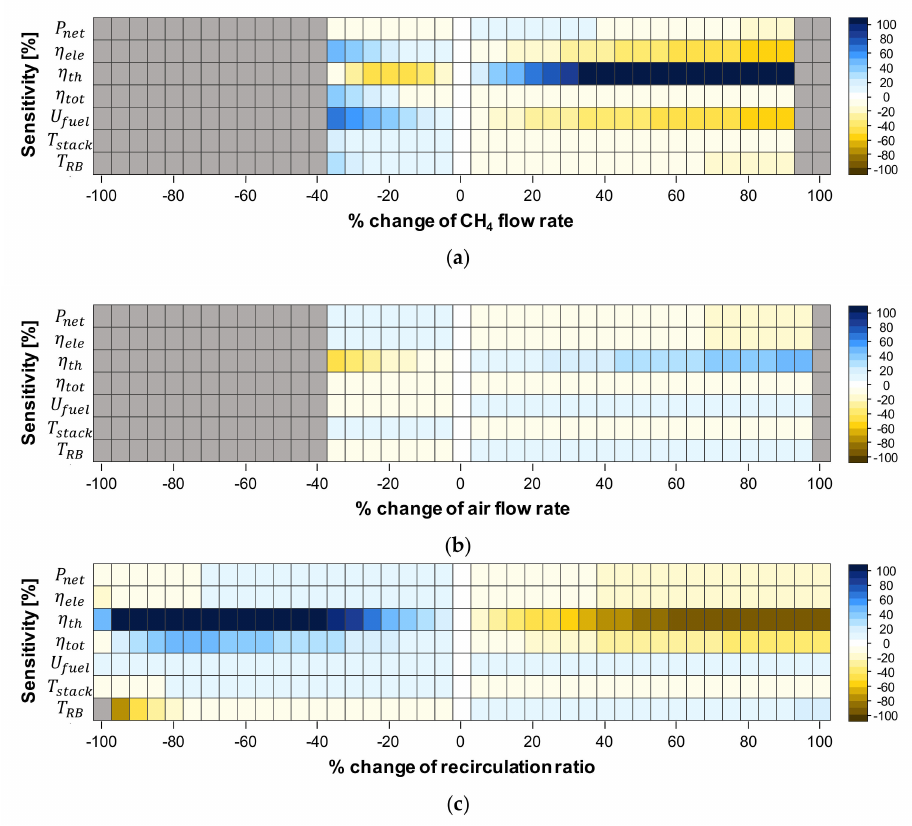
Figure 2. Sensitivity of ( a ) CH 4 flow rate, ( b ) air flow rate, and ( c ) recirculation ratio on performance characteristics. Table 6. The result of sensitivity analysis of each parameter. 1. Sensitivity of CH 4 Flow Rate to System Performance